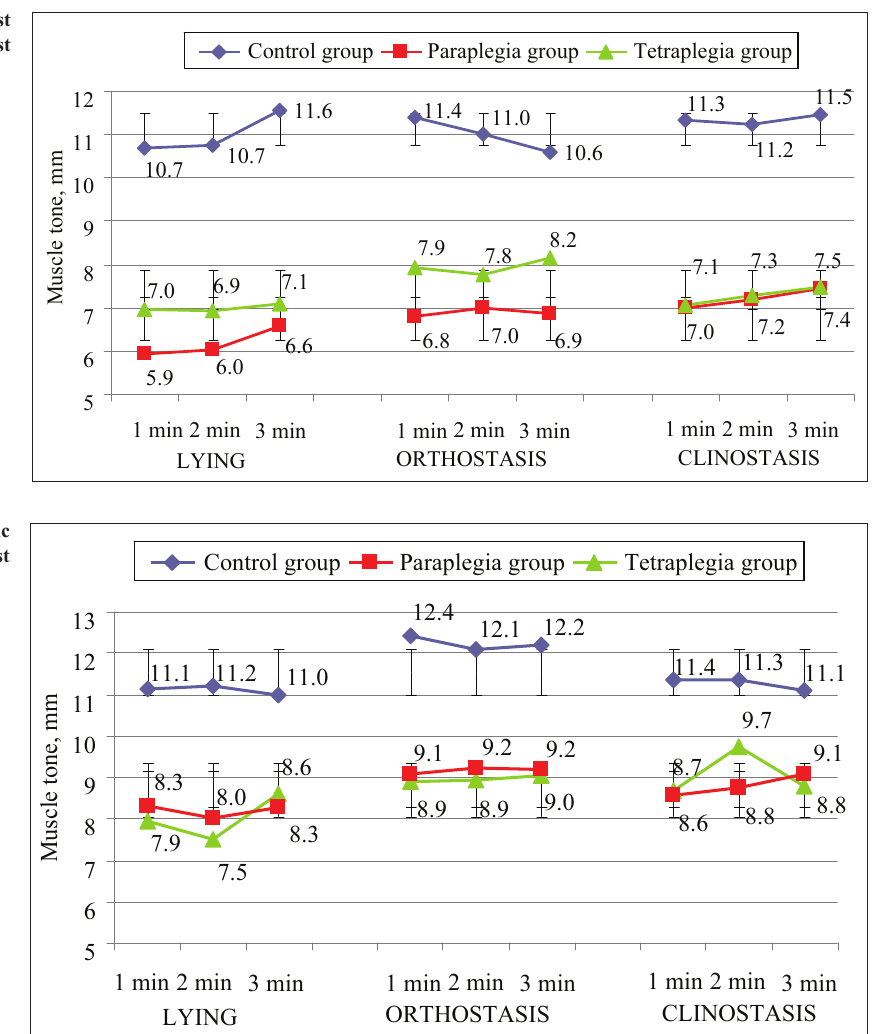
Figure 4. Thigh myotonometric test results in ortho-clinostatic test (averages)